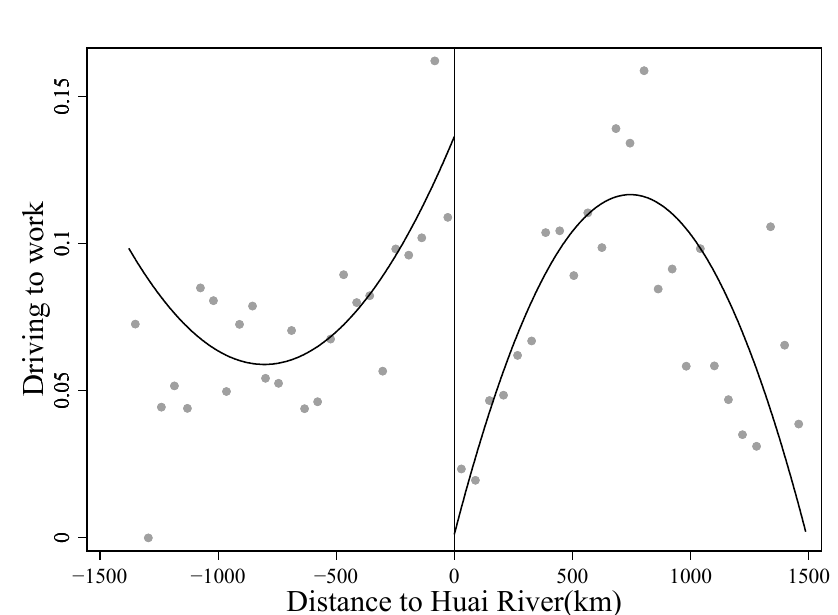
Figure A1. RD plot for driving to work. Notes: The figure shows the binned averages of driving to work against the running variable. The solid line represents a quartic polynomial fit of driving to work by car on each side of the threshold.